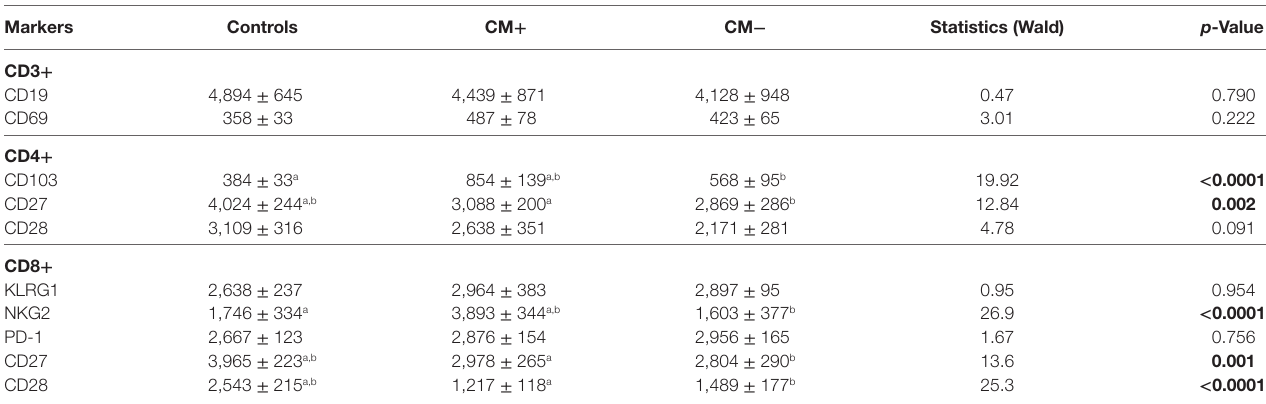
TaBle 4 | Expression of activated and regulatory markers as determined by the mean fluorescence intensity (MFI). Markers